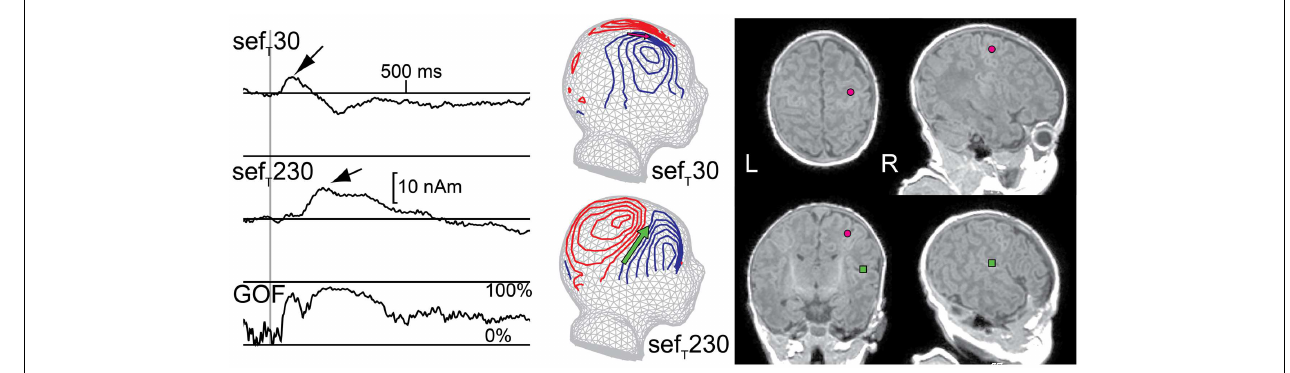
spherical surface and projected onto a schematic newborn head. Right: SI (pink circle) and SII (green square) ECD locations on the newborn’s axial, coronal, and sagittal magnetic resonance images (MRIs). (GOF = goodness of